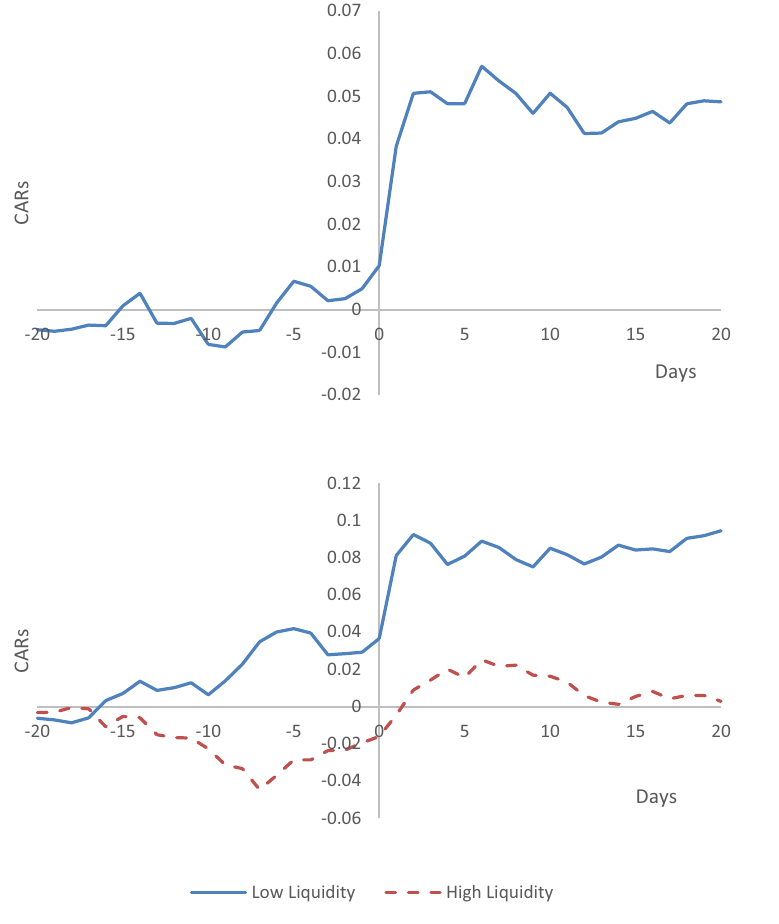
Figure 1. The market reaction